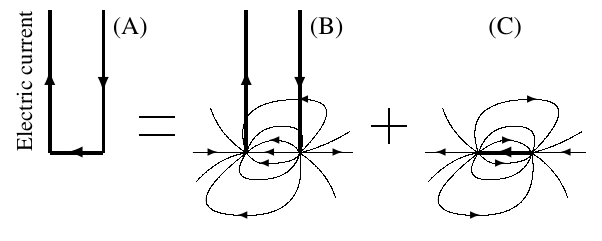
Fig. 5. Simple illustration of Fukushima’s theorem (after Fukushima, 1969, 1985b).